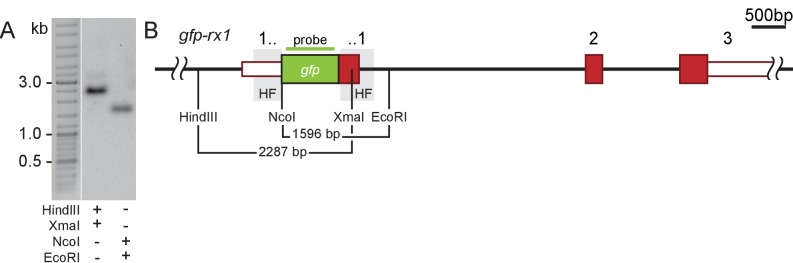
Stably transmitted single-copy integration of the gfp-rx1 donor cassette.(A) Southern Blot analysis of F2 gfp-rx1 embryos reveals a single band for a digestion scheme cutting outside the donor cassette and within the 3’ donor cassette (HindIII/XmaI) or within the 5’ donor cassette and in intron 1 (NcoI/EcoRI) indicating precise single-copy donor integration. (A’) Schematic representation of the modified locus indicating the restriction sites and the domain complementary to the probe used in (A).